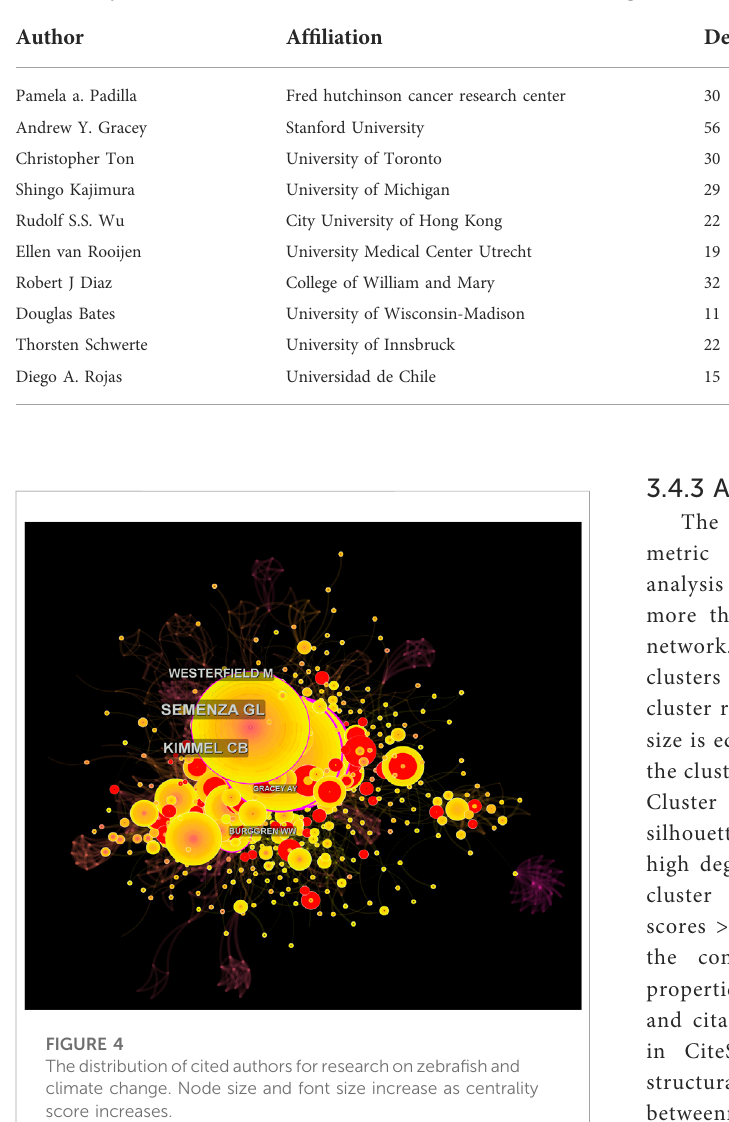
TABLE 5 Top 10 authors co-citation score for Zebra fi sh and Climate Change Research